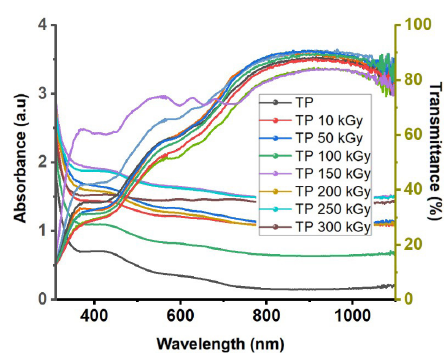
Figure 5. Transmittance and absorbance spectra of different gamma- absorbed doses of TIPS Pentacene.